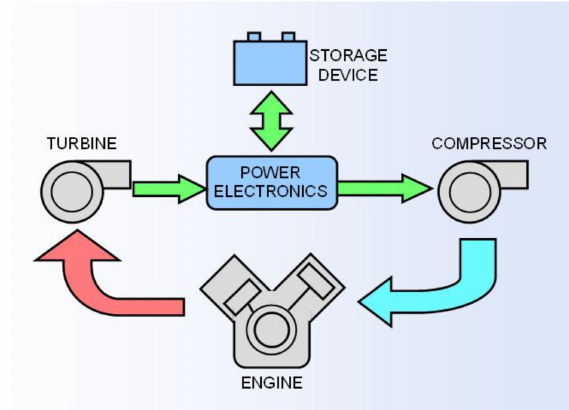
Figure 7. Hybrid Turbo-Compound